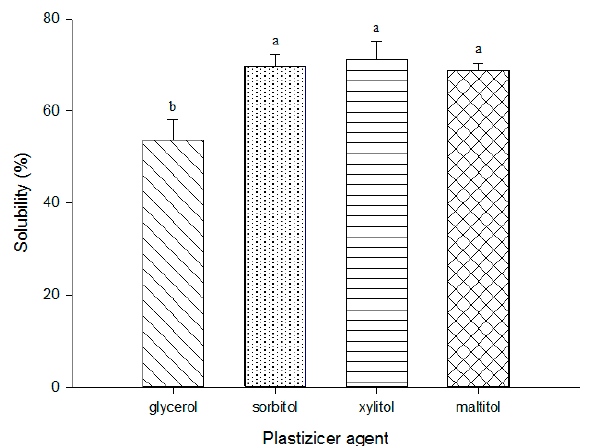
Figure 5. Water solubility of protein films from jumbo squid ( Dosidicus gigas ) with different plasticizers. The values are the means of three determinations ± the standard deviation. Different letters show significant differences ( p < 0.05).